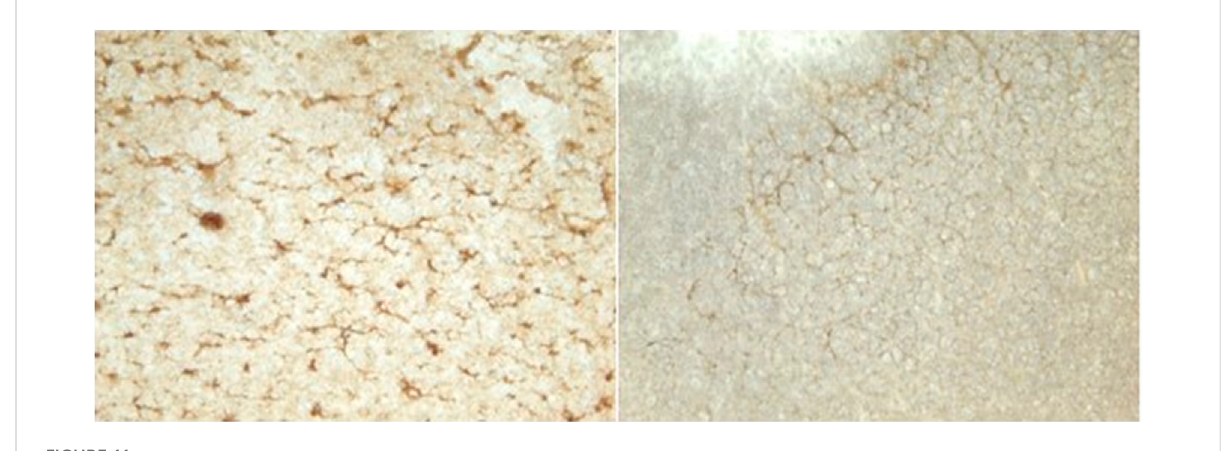
FIGURE 11 Images of gray matter (Section 5) versus white matter (Section